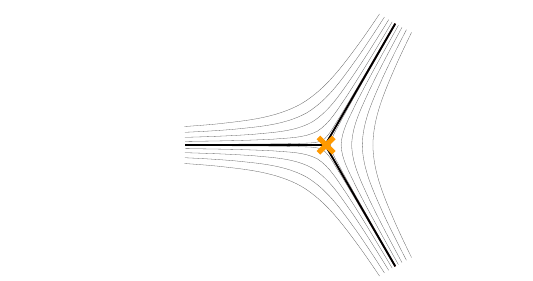
Figure 10 . A leaf with its two orientations labeled.